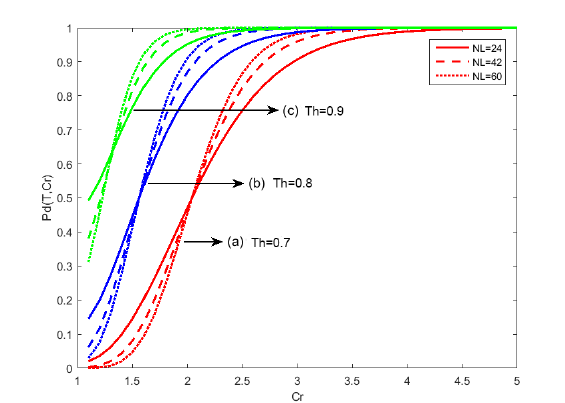
Figure 7. Pd for different decision thresholds Th . ( a ) Th = 0.7; ( b ) Th = 0.8; ( c ) Th =